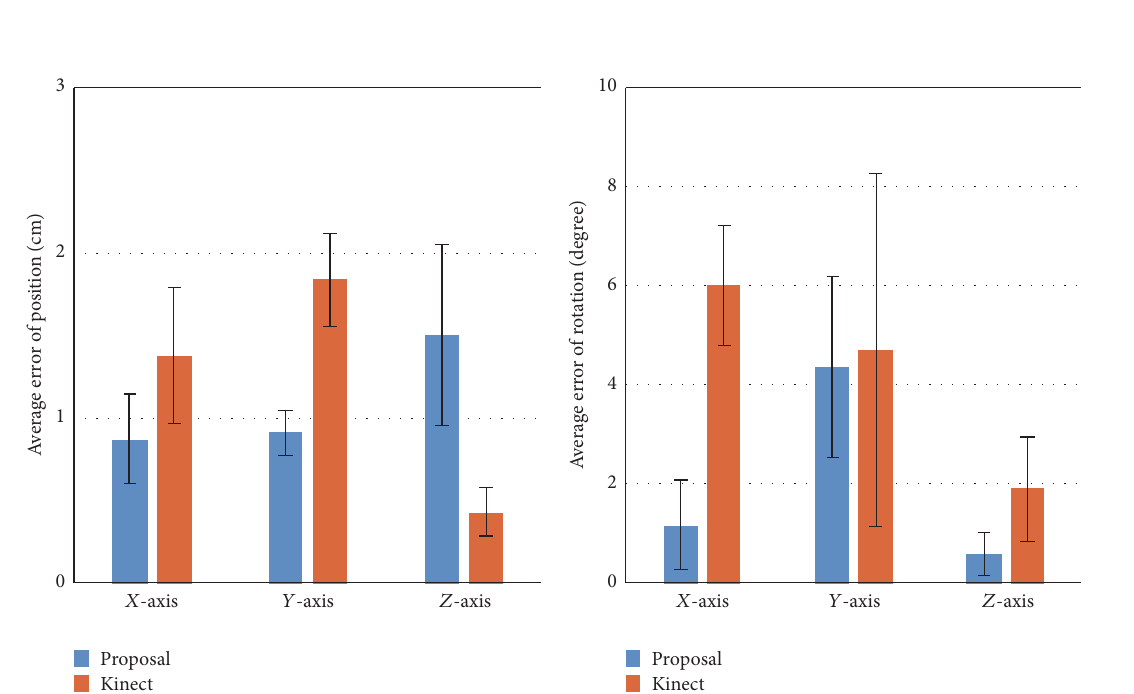
Figure 13: Average error of tracked